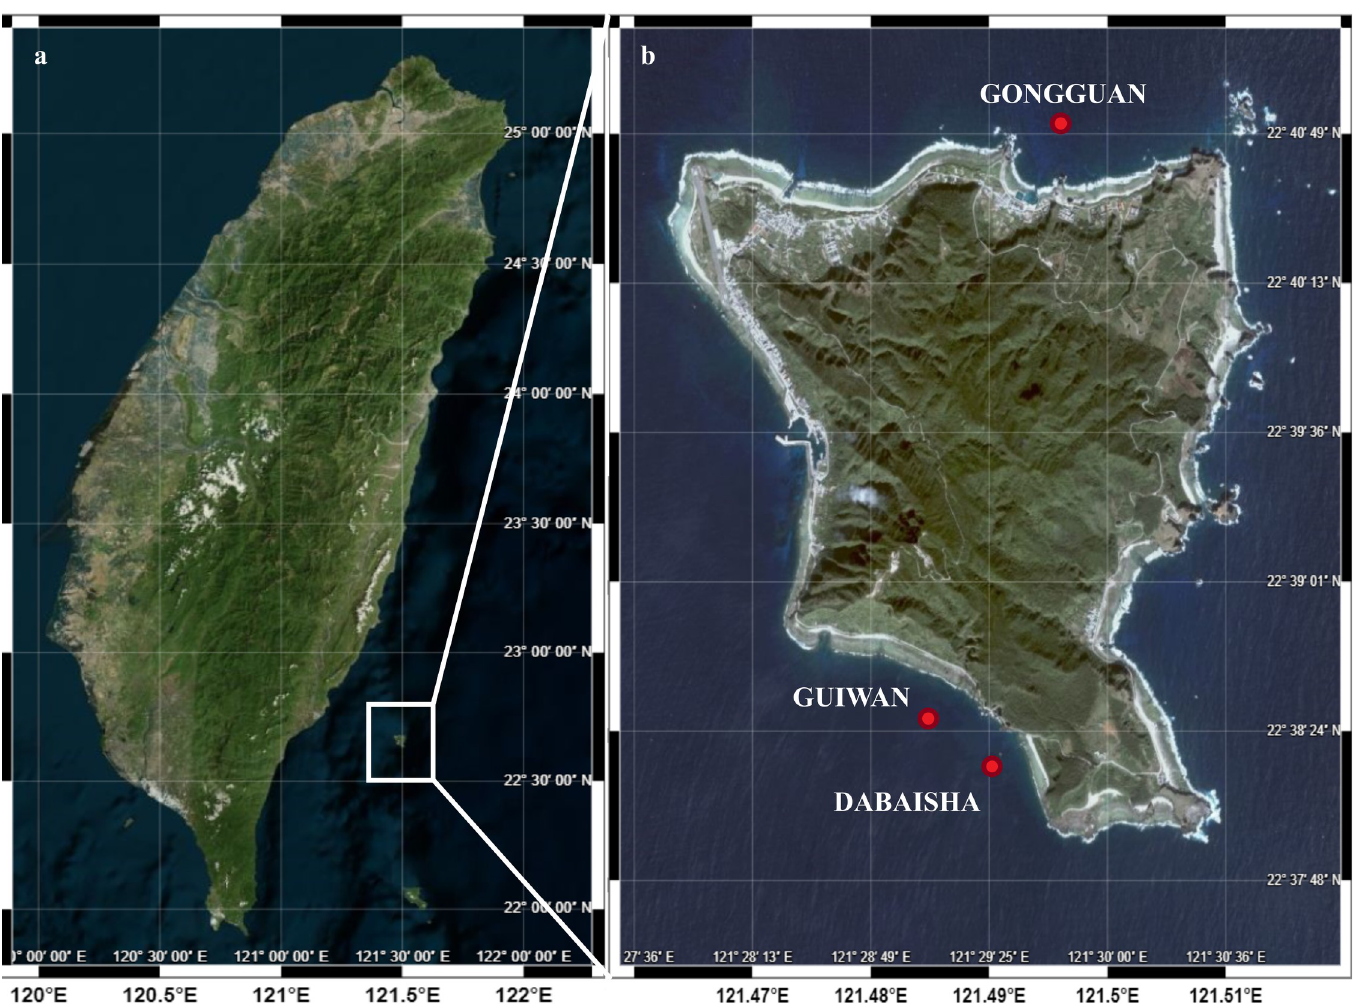
Fig 1. Ludao, Taiwan; and sampling sites. a. Ludao; b. Details of the island with position of the sampling sites Gongguan, Guiwan, and Dabaisha. Source: Ocean Data Bank, National Taiwan University (http://www.odb.ntu.edu.tw/).